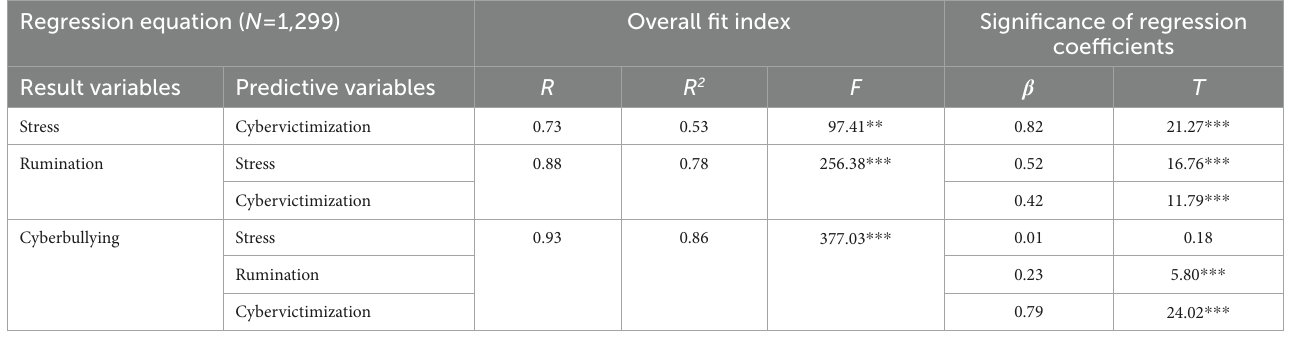
TABLE 2 Regression analysis of the relationship between the variables in the chain mediation model. Regression equation ( N =